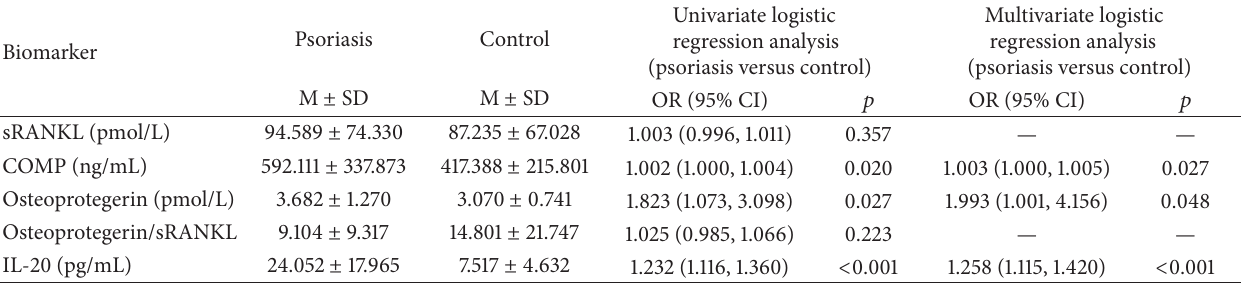
Table 2: The biomarkers serum concentrations in the psoriatic patients compared to the control group.